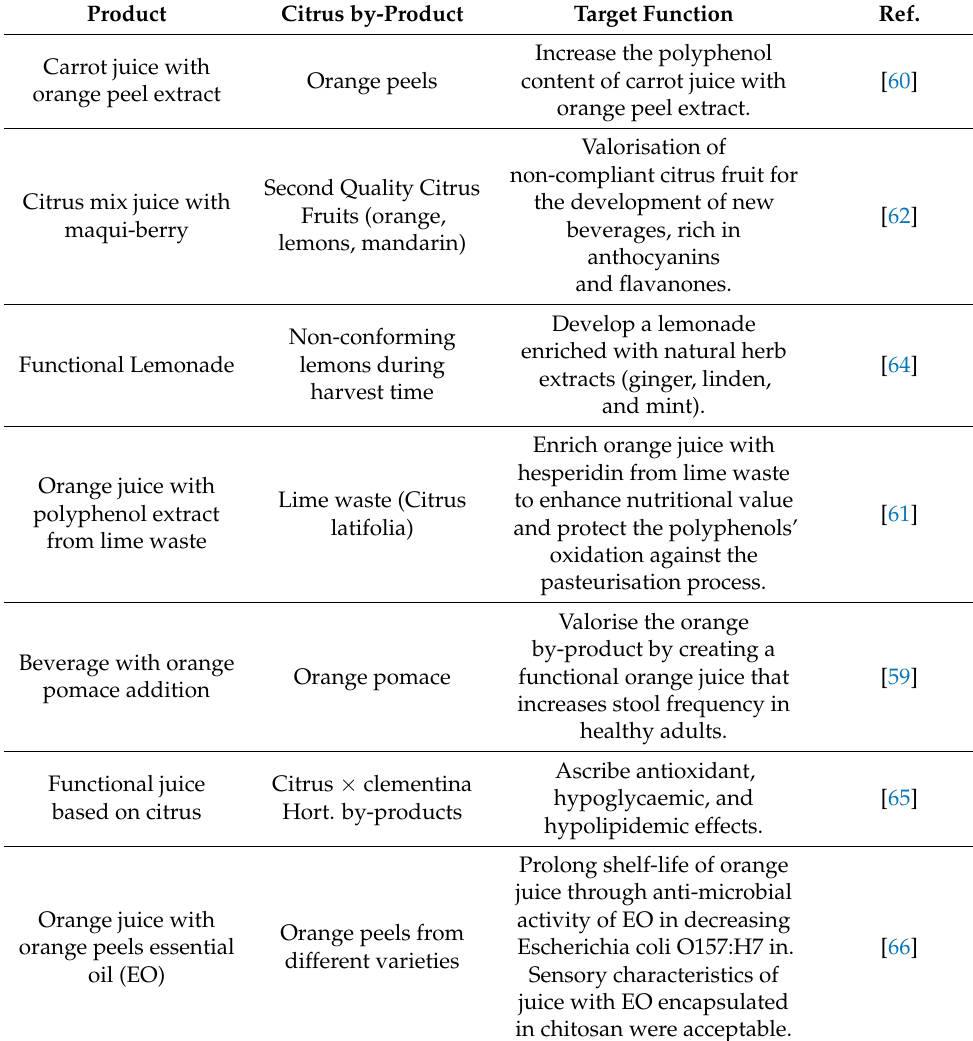
Table 2. Examples of functional citrus-based beverages with citrus